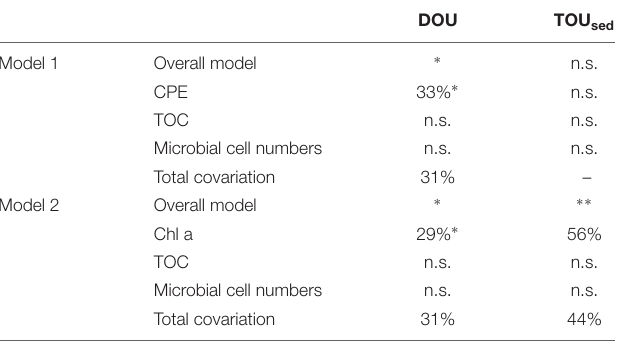
TABLE 3 | Results of partitioning the variation in DOU and TOU sed across shelf and deep-sea stations sampled during Polarstern expedition PS94 (only significant models are shown; for other models tested, see Supplementary Table S2 . DOU TOU